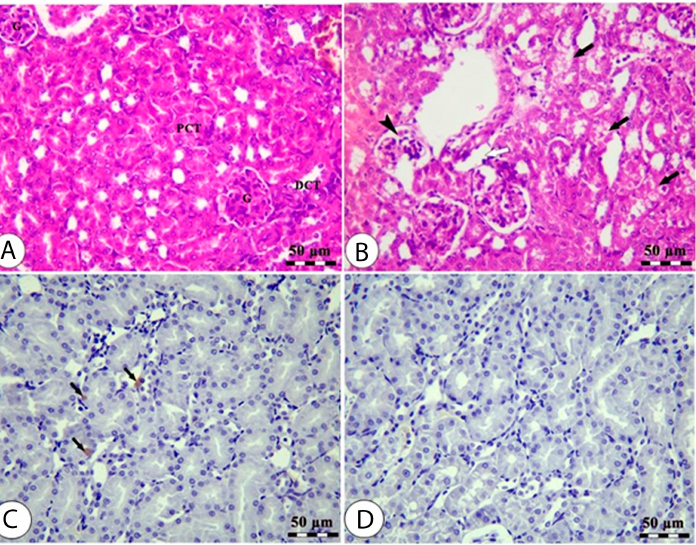
Figure 4. Kidney sections of normal sea level ( A , C ) and high altitude ( B , D ) groups stained by H&E (A&B) and HO-1 IHC ( C , D ). The H&E-stained kidney sample from the normal sea level group ( A ) shows normal glomeruli (G), normal proximal (PCT), and distal (DCT) convoluted tubules. The H&E-stained kidney sample from the high-altitude group ( B ) shows degenerated glomeruli (black arrowhead), degenerated renal tubules (black arrows), and interstitial edema (white arrow). The HO-1 IHC-stained kidney sample from the normal sea level group ( C ) shows renal tubules with mildly positive HO-1 staining (black arrows). The HO-1 IHC-stained kidney sample from the high-altitude group ( D ) shows renal tubules with less HO-1 staining. Table 5. Histopathological changes as described by H&E and immunoexpression of HO-1 and Nrf-2 in the hepatic and renal tissues of rats who lived at sea and high altitude levels. Organ Lesion and Immunoexpression Normal Sea Level High Altitude Congestions 0 a Fatty change Inflammatory infiltrate Liver